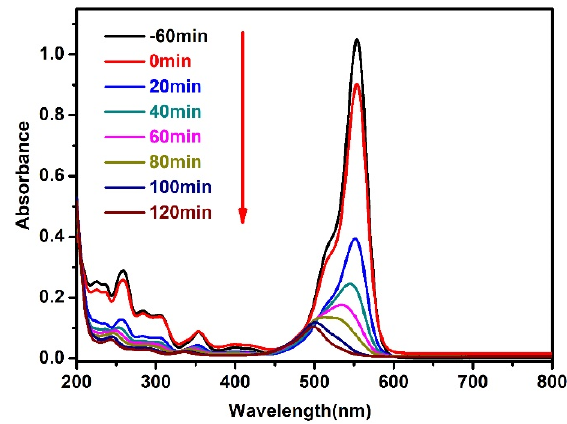
Figure 6. UV–visible spectra of rhodamine B (RhB) solution with time over BMO-CTAB under visible light.